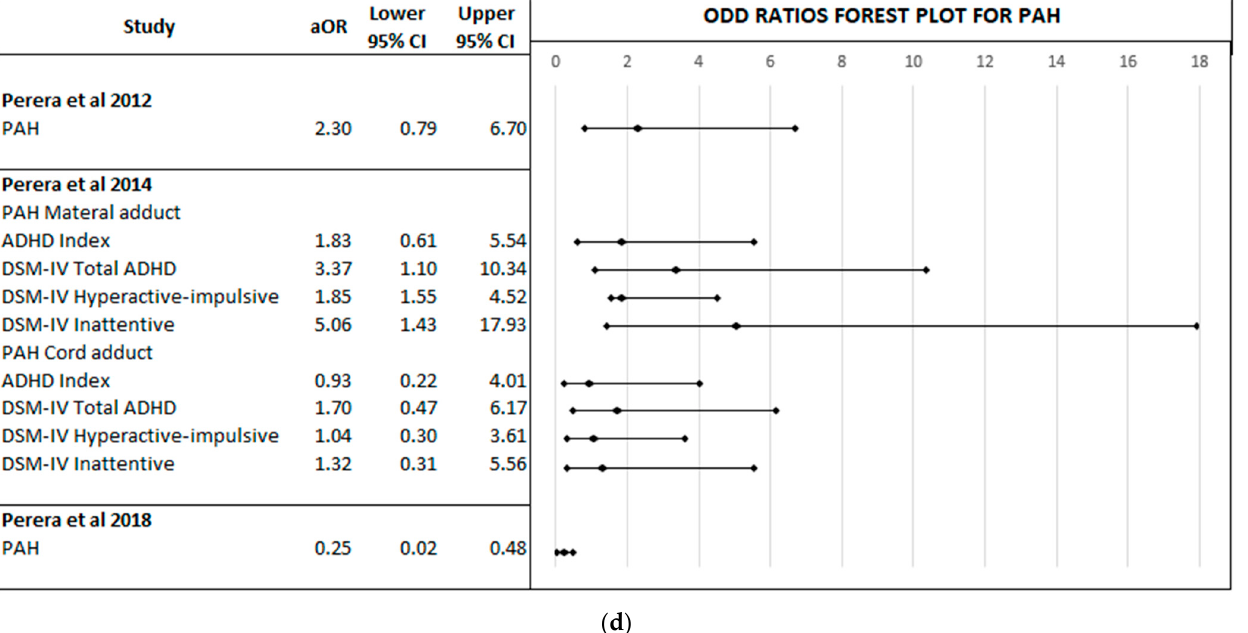
Figure 2. Odd ratios forest plot for each pollutant. ( a ) Odd Ratio Forest Plot of Association between NOx Exposure and ADHD [52,54–57,59,62,65]; ( b ) Odd Ratio forest plot of association between PM exposure and ADHD [52,54–57,61,62,64,65]; ( c ) Odd Ratio forest plot of association between SO2 exposure and ADHD [55,56,62]; ( d ) Odd Ratio forest plot of association between PAH exposure and ADHD [51,53,58].